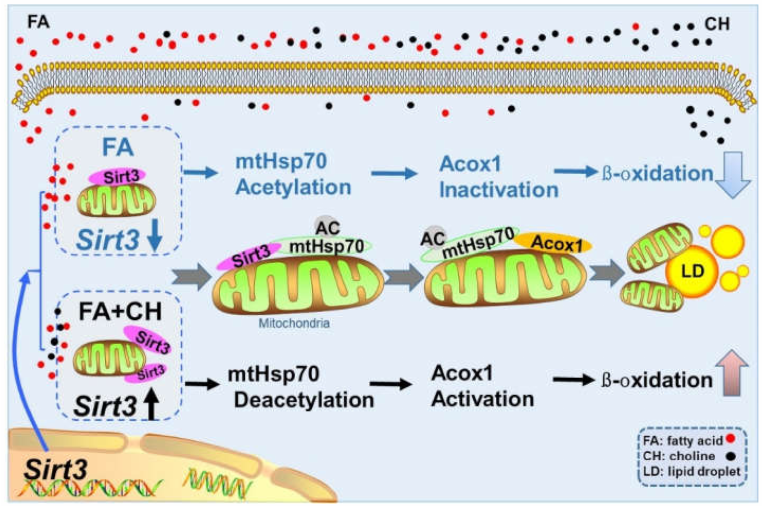
Figure 7. Graphical conclusions for the mechanism of dietary choline alleviating